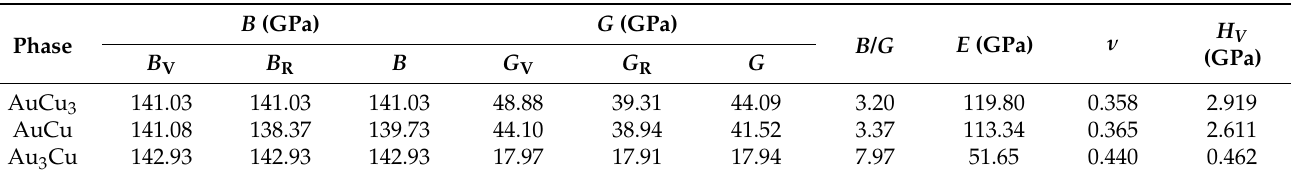
Table 3. Calculated bulk modulus B , shear modulus G , Young’s modulus E , B / G ratio, Poisson ratio ν , and Vickers hardness H V of Au–Cu